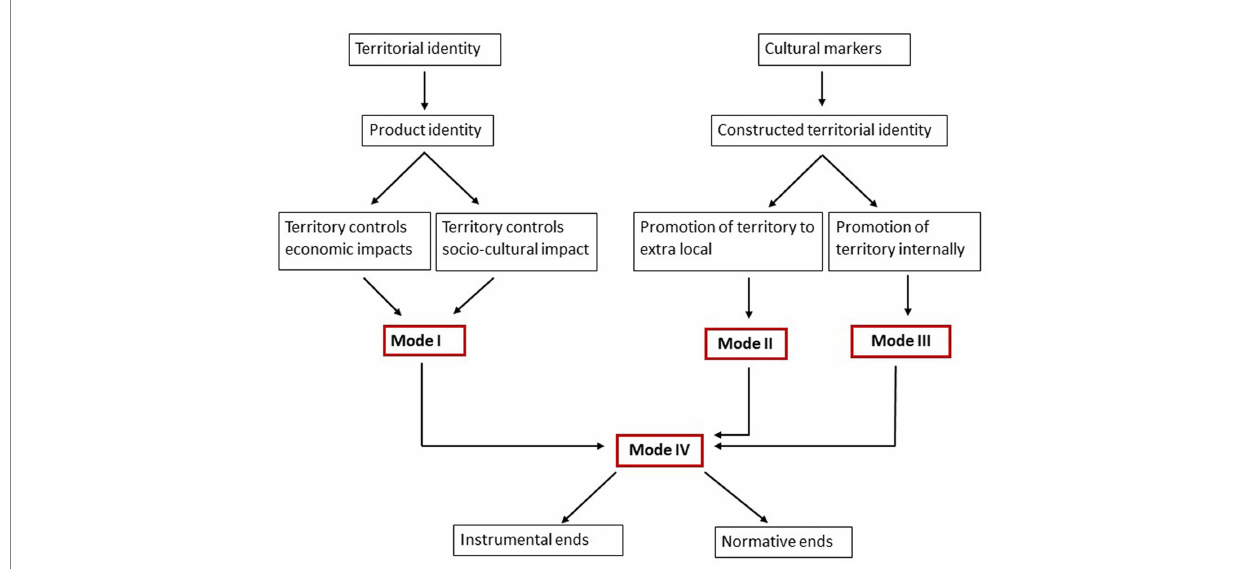
FIGURE 1 Model of neo-endogenous development by Ray, 2001, created by the authors.